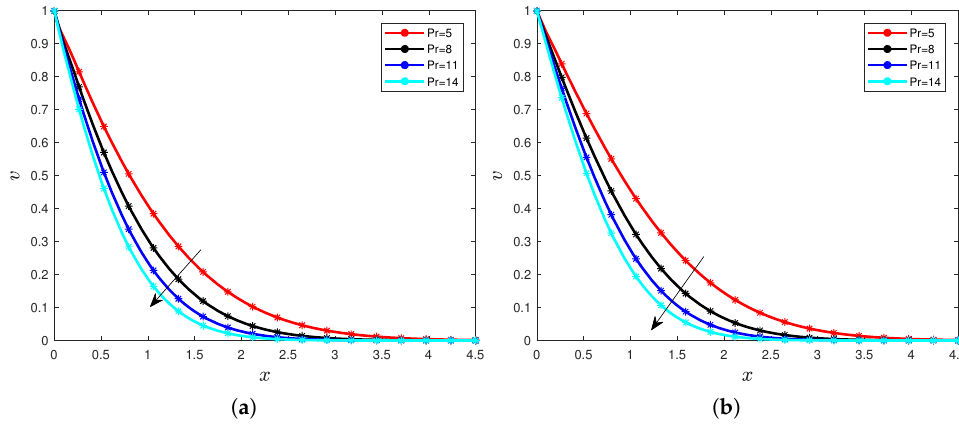
Figure 12. Temperature for different values of the Prandtl number with α = 0.85 ( a ) and α = 0.95 ( b ).